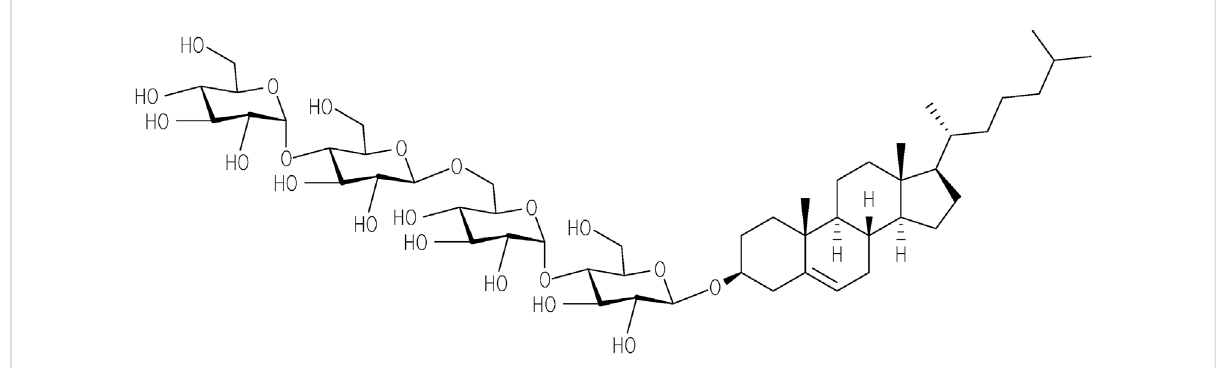
FIGURE 1 Chemical structure of Chobimalt (Howell et al.,